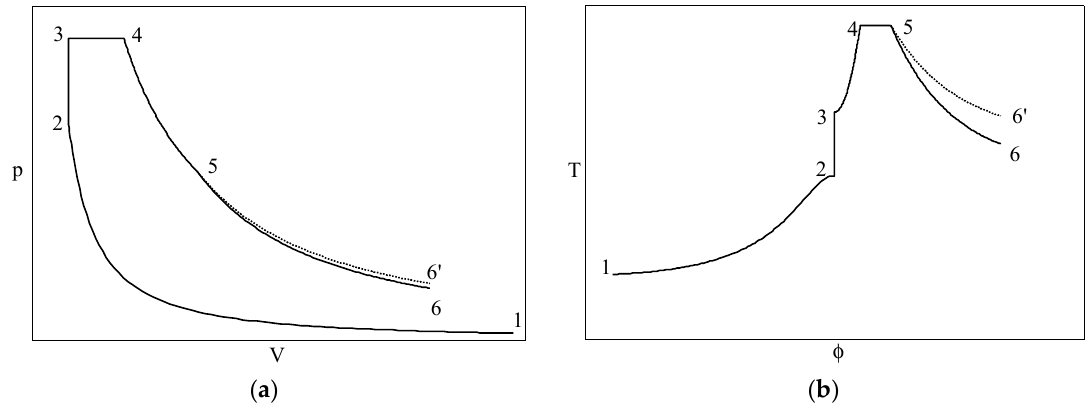
Figure 4. Six-point Seiliger process definition: ( a ) p - V diagram; ( b ) T - φ diagram.